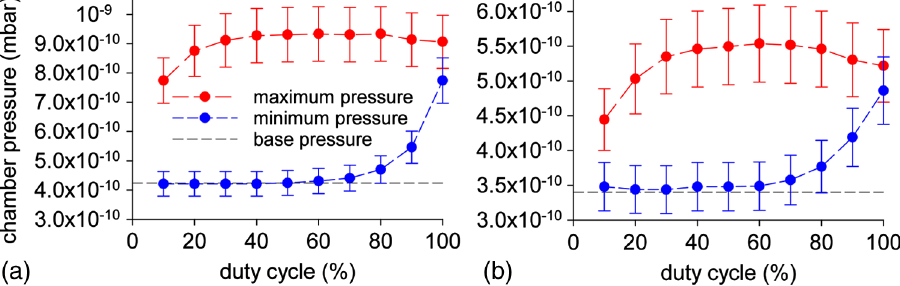
FIG. 14. Plot of pressure at (a) differential chamber and (b) dump chamber verses pulsed valve duty cycle; the period of the pulsed valve is 1 s, pressure at the pulsed valve is 2 bar and helium is the gas